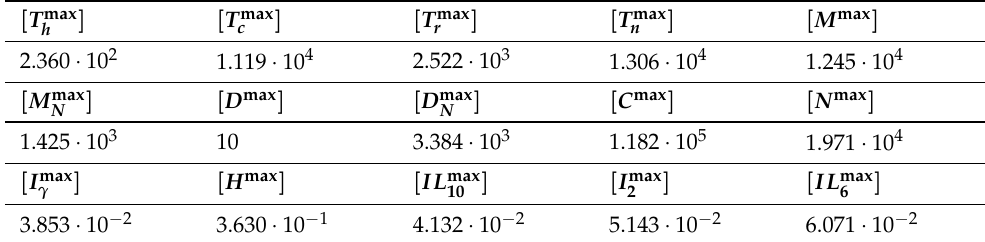
Table A2. Steady state values of the variables derived from the largest tumors from each